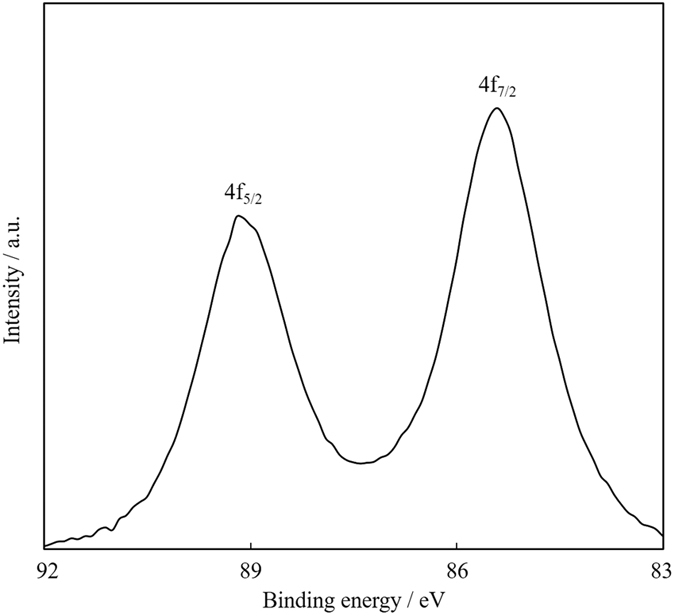
XPS spectrum of purified Au NPs for Au4f region.